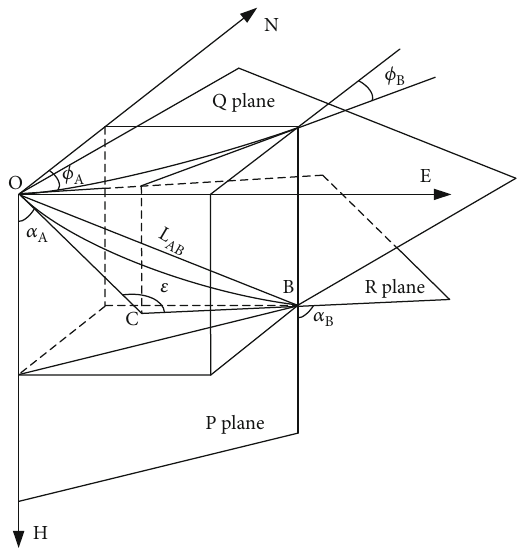
Figure 1: Three-dimensional plane decomposition of borehole